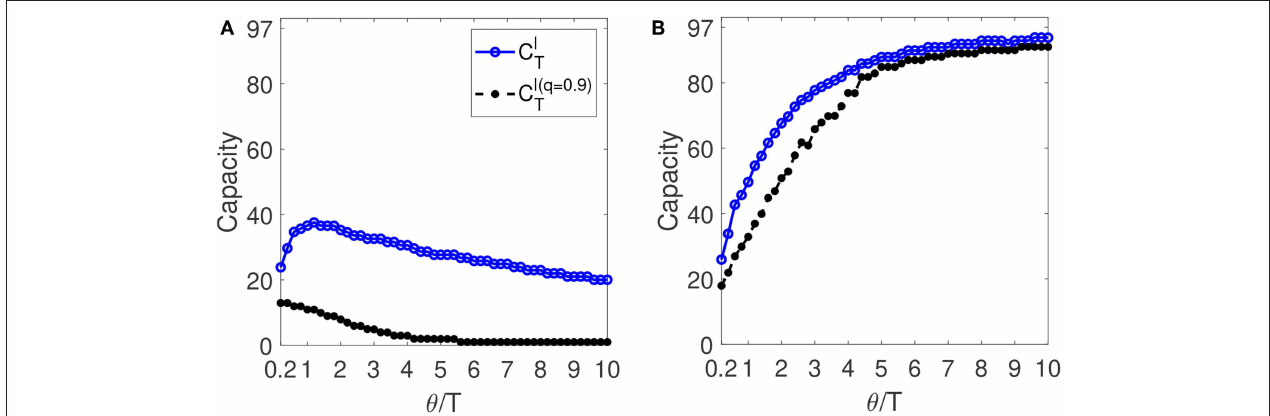
FIGURE 2 | Computational capacity of the linear delay-based RC with one delay line as a function of θ/ T for (A) α = 0 and (B) α = 1. The solid line with blue circles is the total computational capacity ( C l T ) and the dashed line with black points is the total quality computational capacity calculated for q =